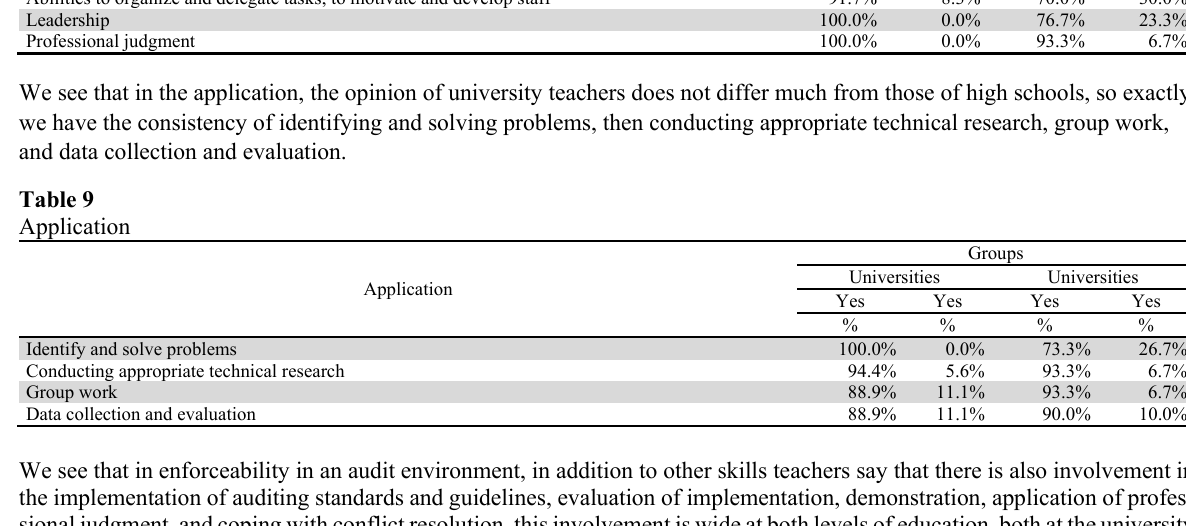
Applicability in an audit environment